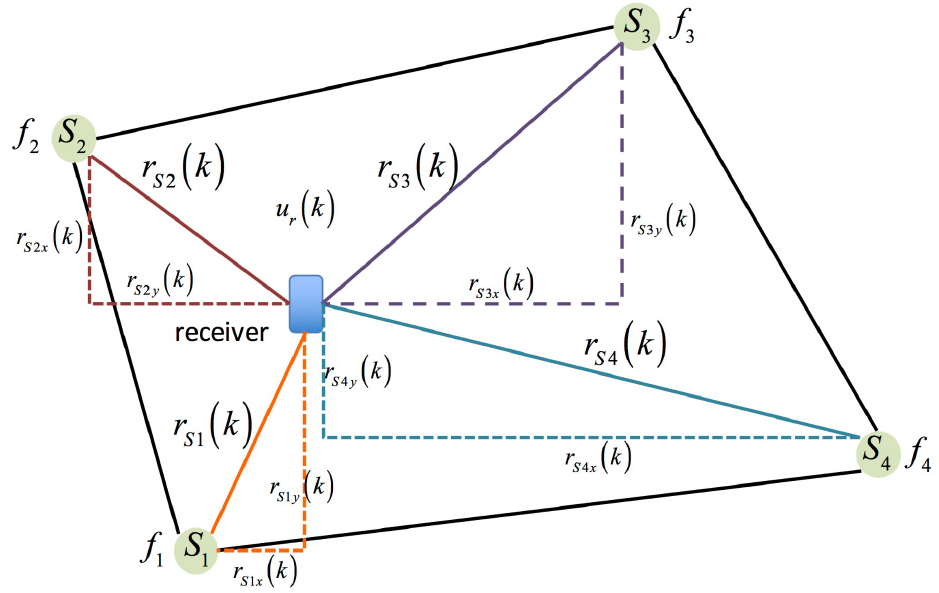
Figure 3. The geometric relationship between the tagged sound sources and the receiver in an indoor plane.